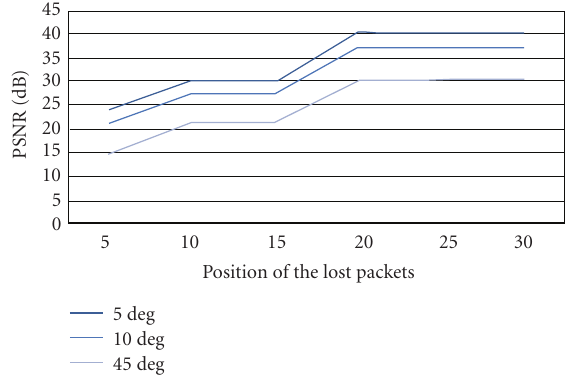
Figure 16: Goku : loss of a batch of 5 consecutive packets of depth information.